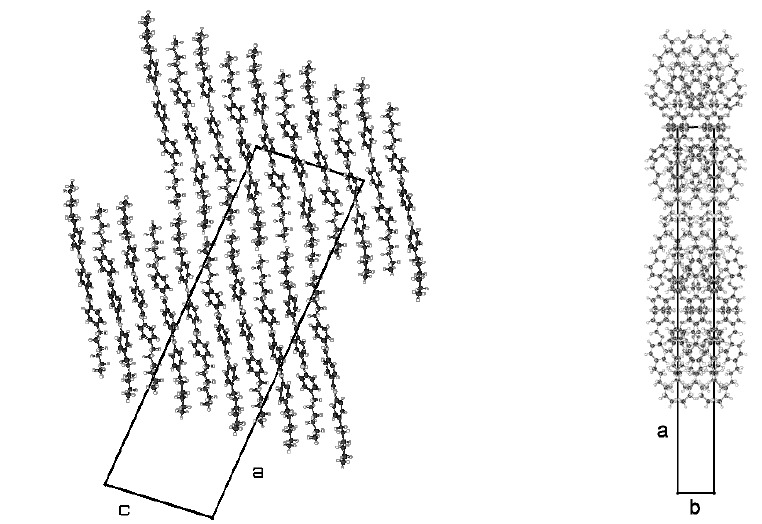
Figure 34. Representation of the packing arrangement of TBAA-6, space group C2/c, in projection on the a,c- and b,c-plane. Note: the similarities with TBAA-3 in Figure